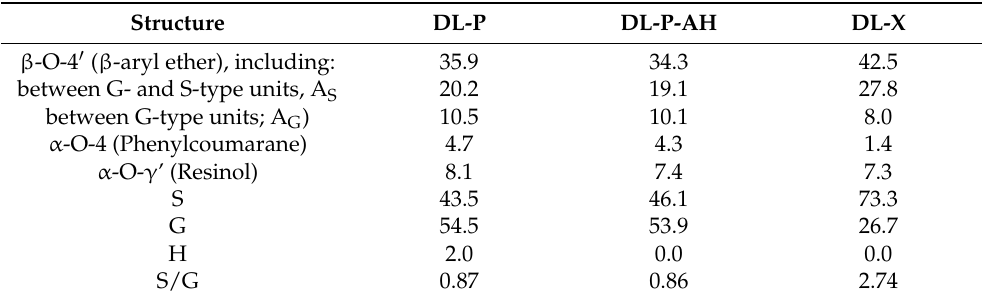
Table 4. Abundance of inter-unit linkages and S-, G-, H-type structures in lignin preparations (per 100 phenylpropane units) according to NMR spectroscopy